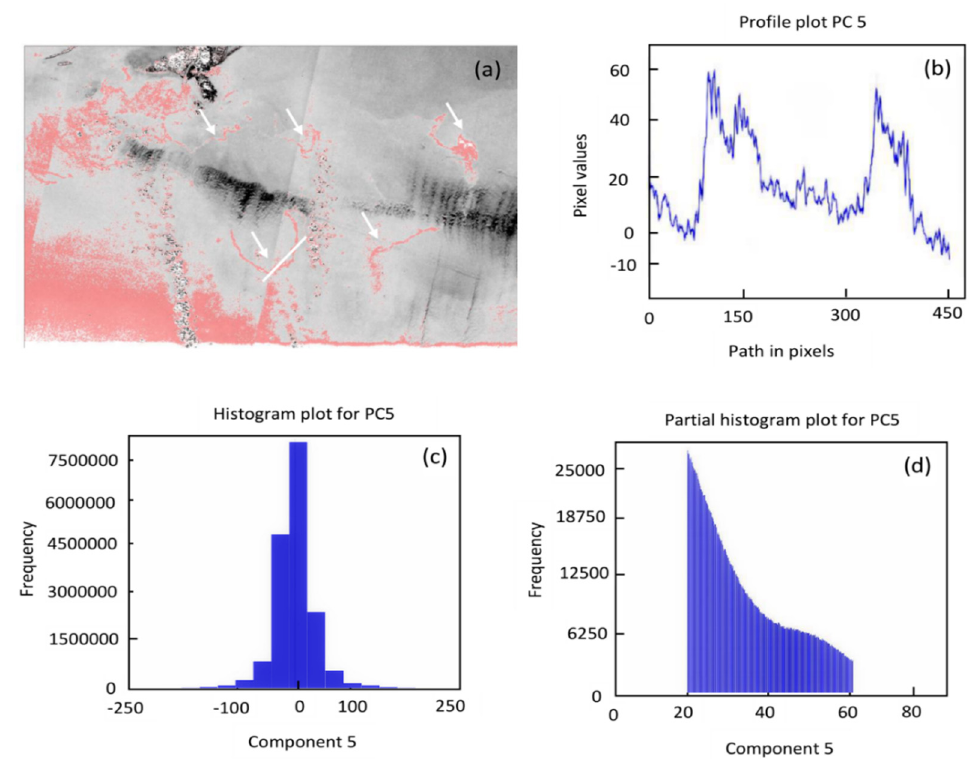
Figure 6. ( a ) The PCA component 5 estimated from Sentinel-2 bands on 4 September 2021, ( b ) Cross-section profile plot of component 5, ( c ) Component 5 histogram, ( d ) Component 5 partial histogram for predefined values.